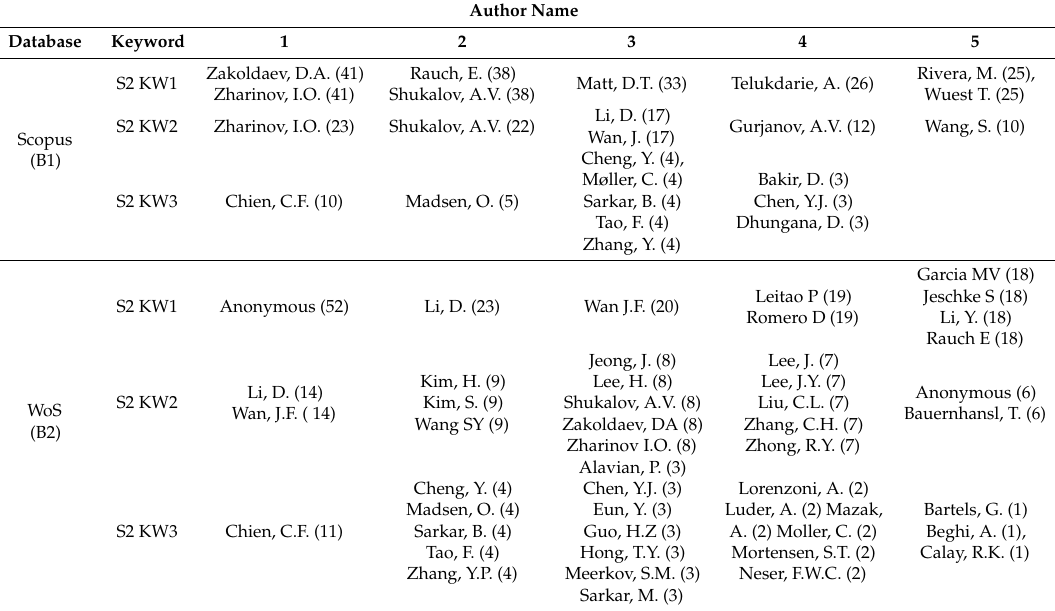
Table 8. Number of published scientific papers according to author names (TOP 5).